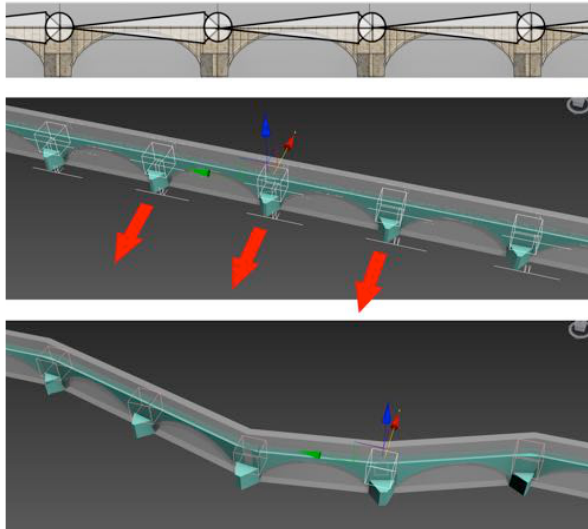
Figure 8. The bones system, created to control the bridge’s path